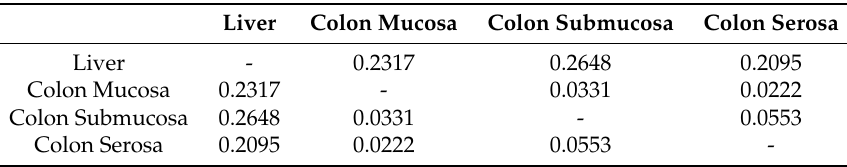
Figure 20. Aluminum nanostructure response for different human body tissues (zoomed). Table 4. Variation (sensibility) of the gain at 500